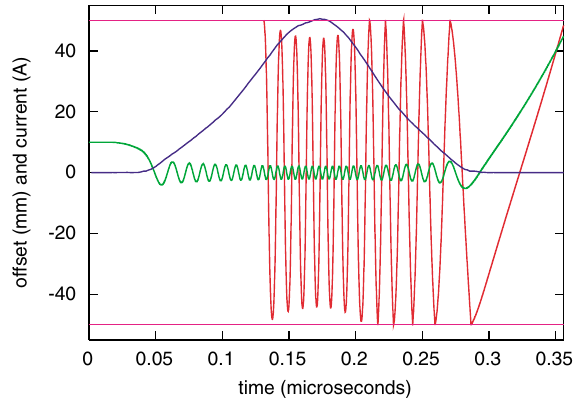
FIG. 4. (Color) Proton beam current (blue) and positions for captured (green) and loss created (red) electrons. The beam pipe radius is 50 mm